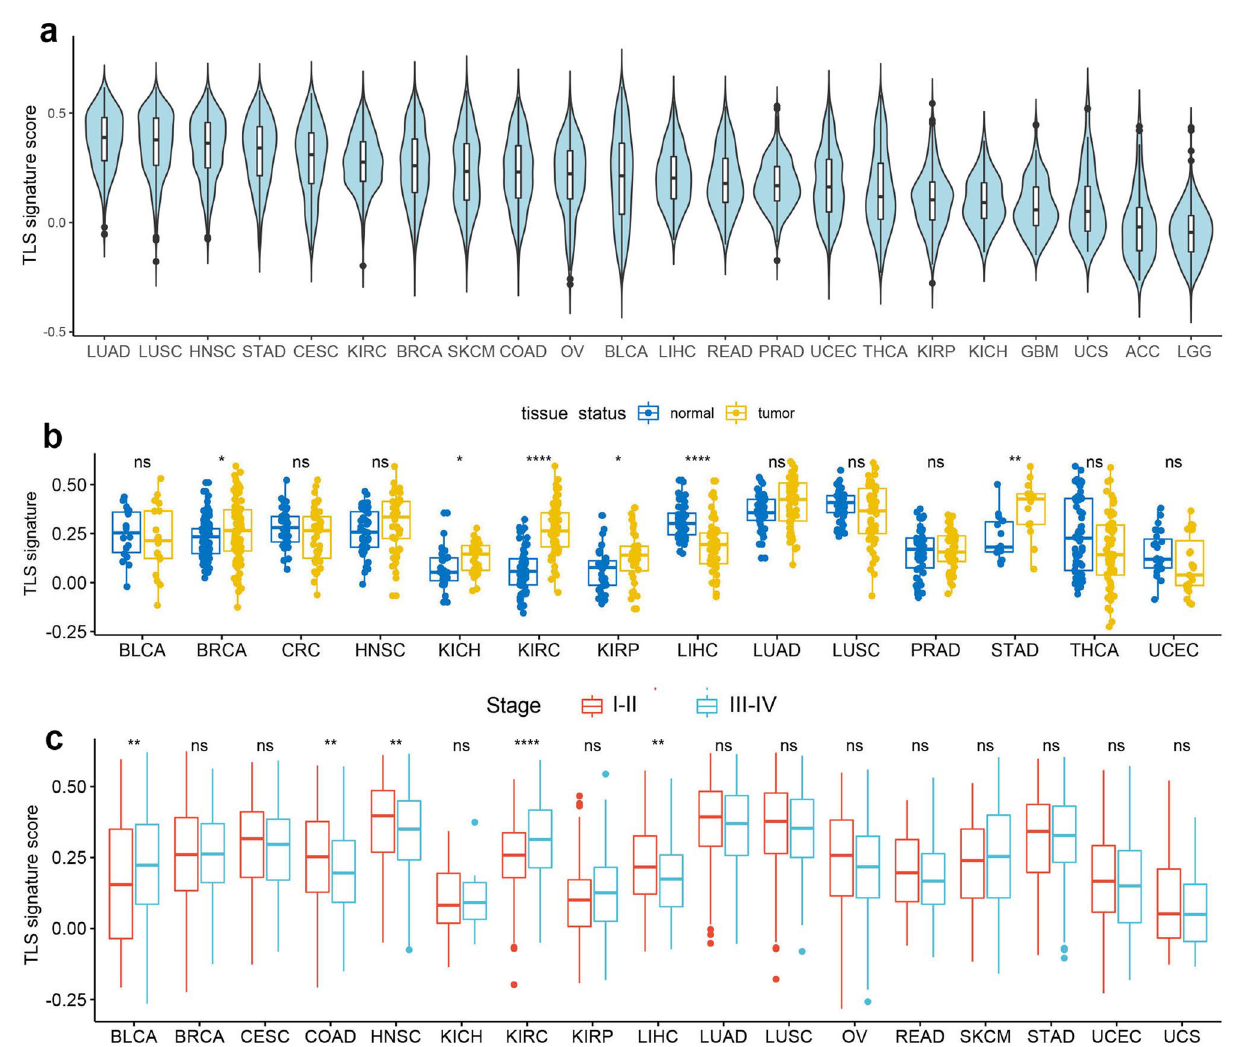
Figure 1. Pan-cancer analysis of TLS based on 12-chemokine signature. ( a ) Expression of TLS signature across 22 solid tumor types; ( b ) Comparison of TLS signature expression between tumor tissue and matched adjacent normal tissue; ( c ) Comparison of TLS signature expression between early-stage tumors (stage I–II) and advanced tumors (stage III–IV). * P < 0.05; ** P < 0.01; *** P < 0.001; **** P < 0.0001; ns, not